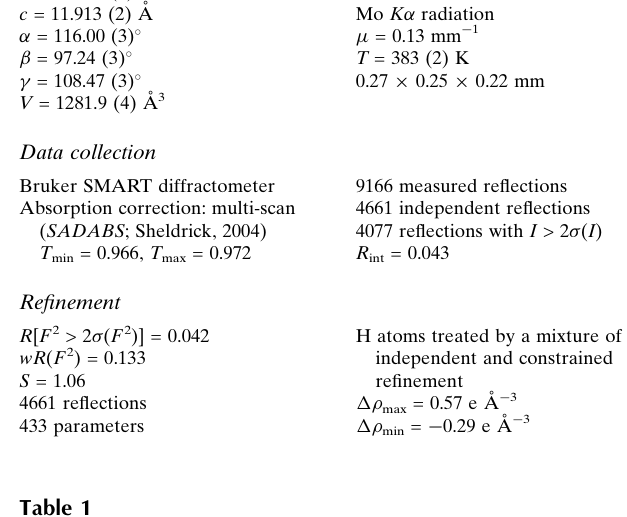
Selected geometric parameters (A˚ , (cid:1)